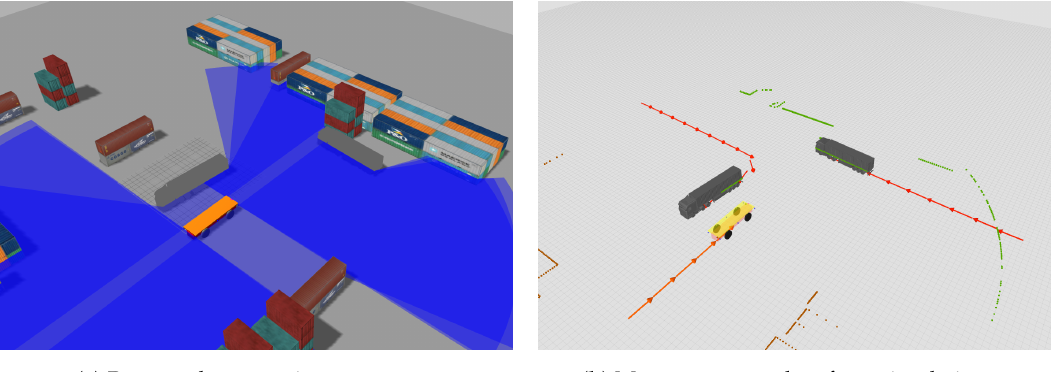
Figure 9. Samples of our simulated environment that recreates real ports conditions. Our simulations include different kind of standard containers, vehicles and other elements such as light posts or road cones. We placed an AGV test platform with Ackermann’s motion model equipped with six SICK LRFs covering 360 ◦ . Trajectories for each vehicle in the scene can be separately defined as are shown in ( b